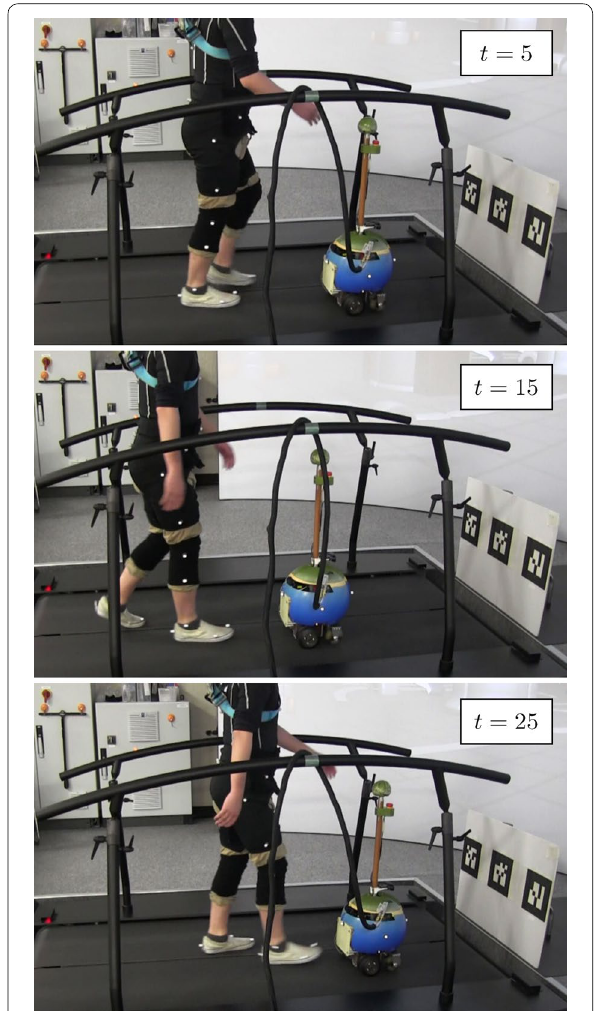
Fig. 8 Snapshots in the user companion test. A user is walking without touching the cane robot for 30 s. These snapshots show the user and robot 5, 15, 25 s after the beginning of the test